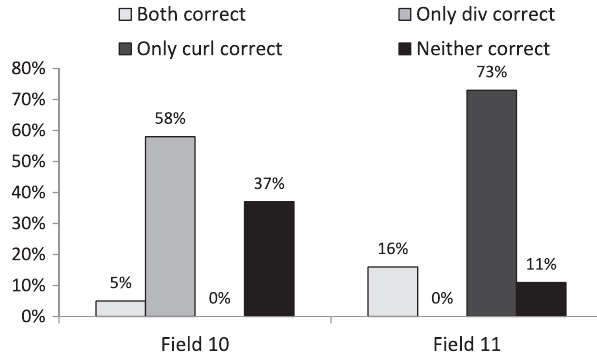
FIG. 3. Percentage of correct answers for the graphical repre- sentation of electromagnetic fields in the post-test ð N ¼ 19 Þ